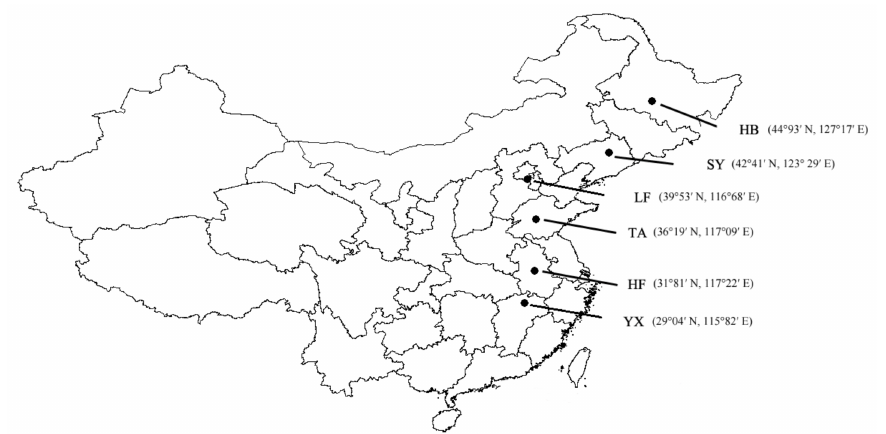
Figure 1. The collection sites of samples of Ostrinia furnacalis . HB: Harbin city, Heilongjiang Province; SY: Shenyang city, Liaoning Province; LF: Langfang city, Hebei Province; TA: Taian city, Shandong Province; HF: Hefei city, Anhui Province; YX: Yongxiu County, Jiangxi